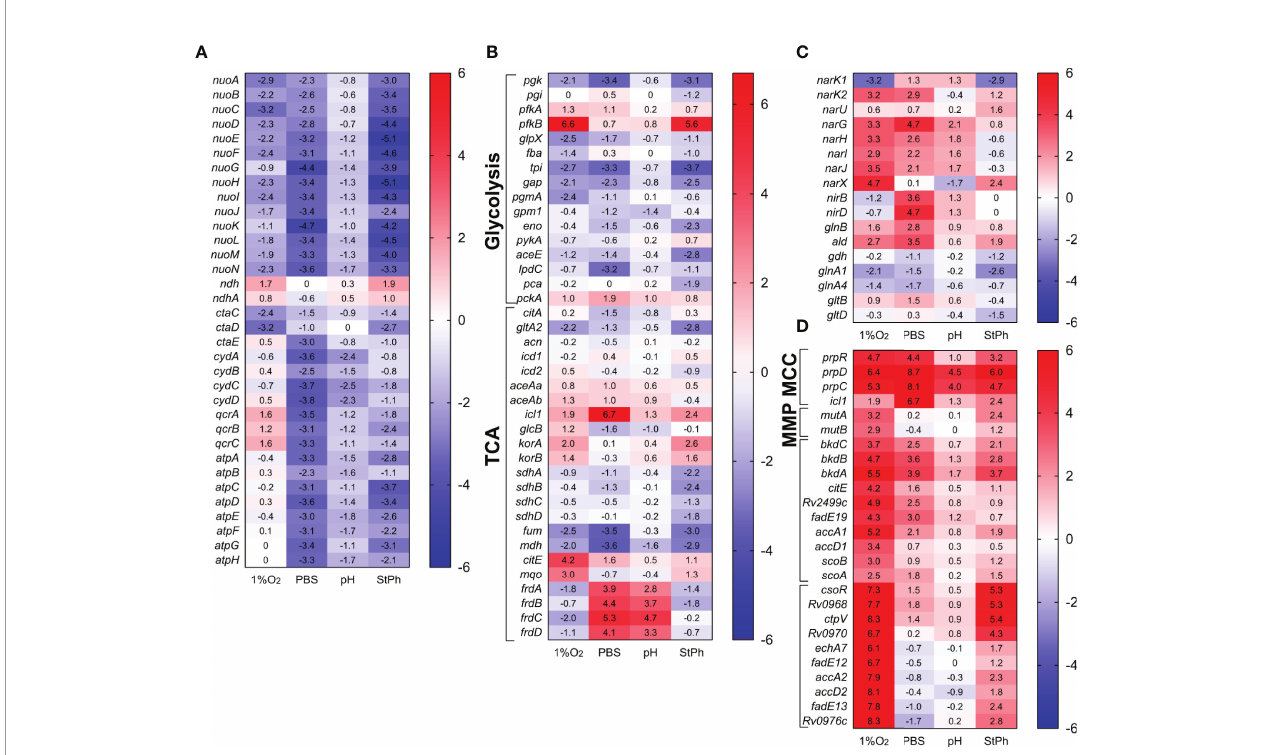
FIGURE 3 | Heat map of genes differentially transcribed in (A) electron transfer chain, (B) glycolysis and tricarboxylic acid cycle (TCA), (C) nitrogen metabolism, (D) propionate metabolism (MCC, methylcitrate cycle; MMP, methylmalonate pathway). The log2 fold change for each gene and condition is indicated in the